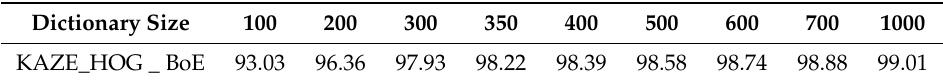
Table 1. Impact of varying dictionary size on average accuracy with the KAZE feature detector (using Mahalanobis and sparse-random combination).